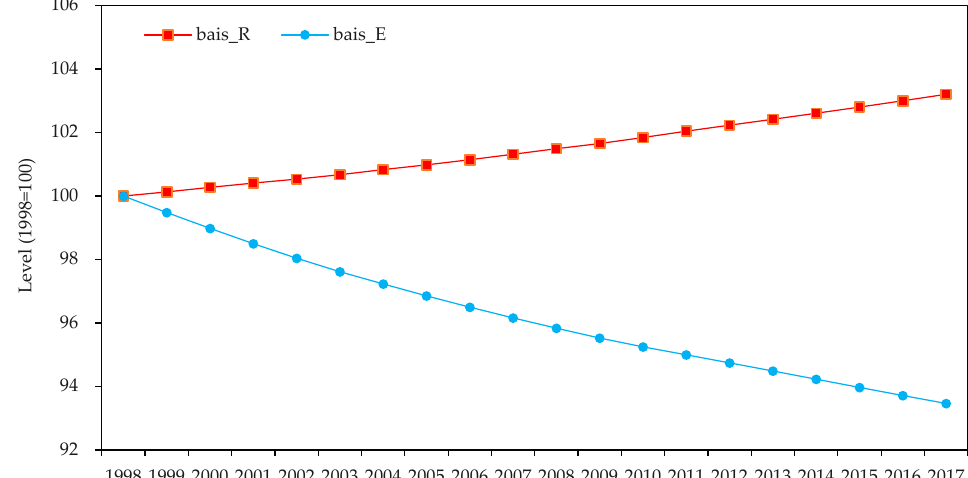
Figure 2. Cumulative green factor bias of technological progress (1998 = 100).